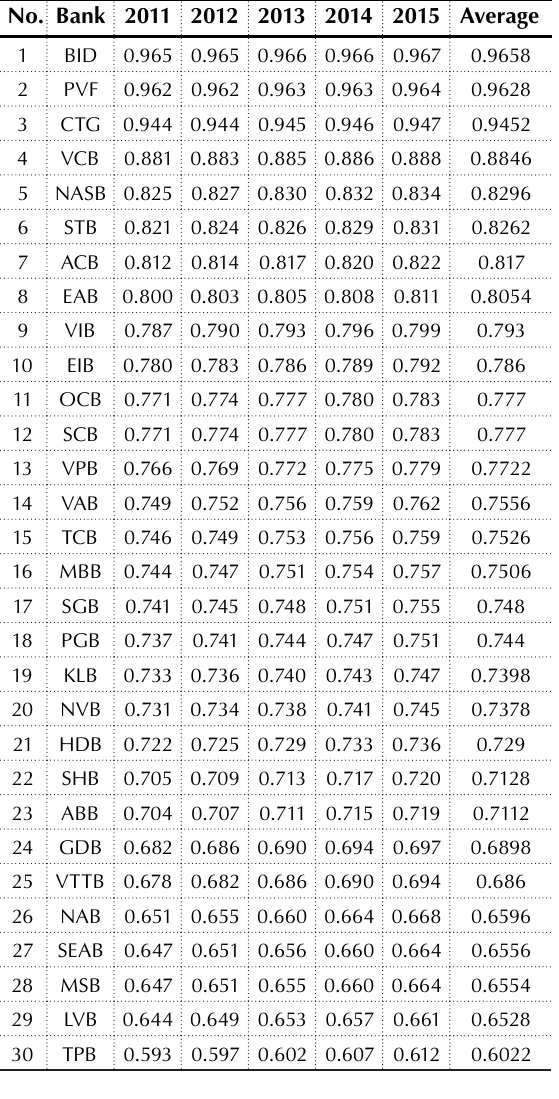
Table 3. Results of calculating the business performance of banks in model 1 Source: Results analysis based on FRONTIER